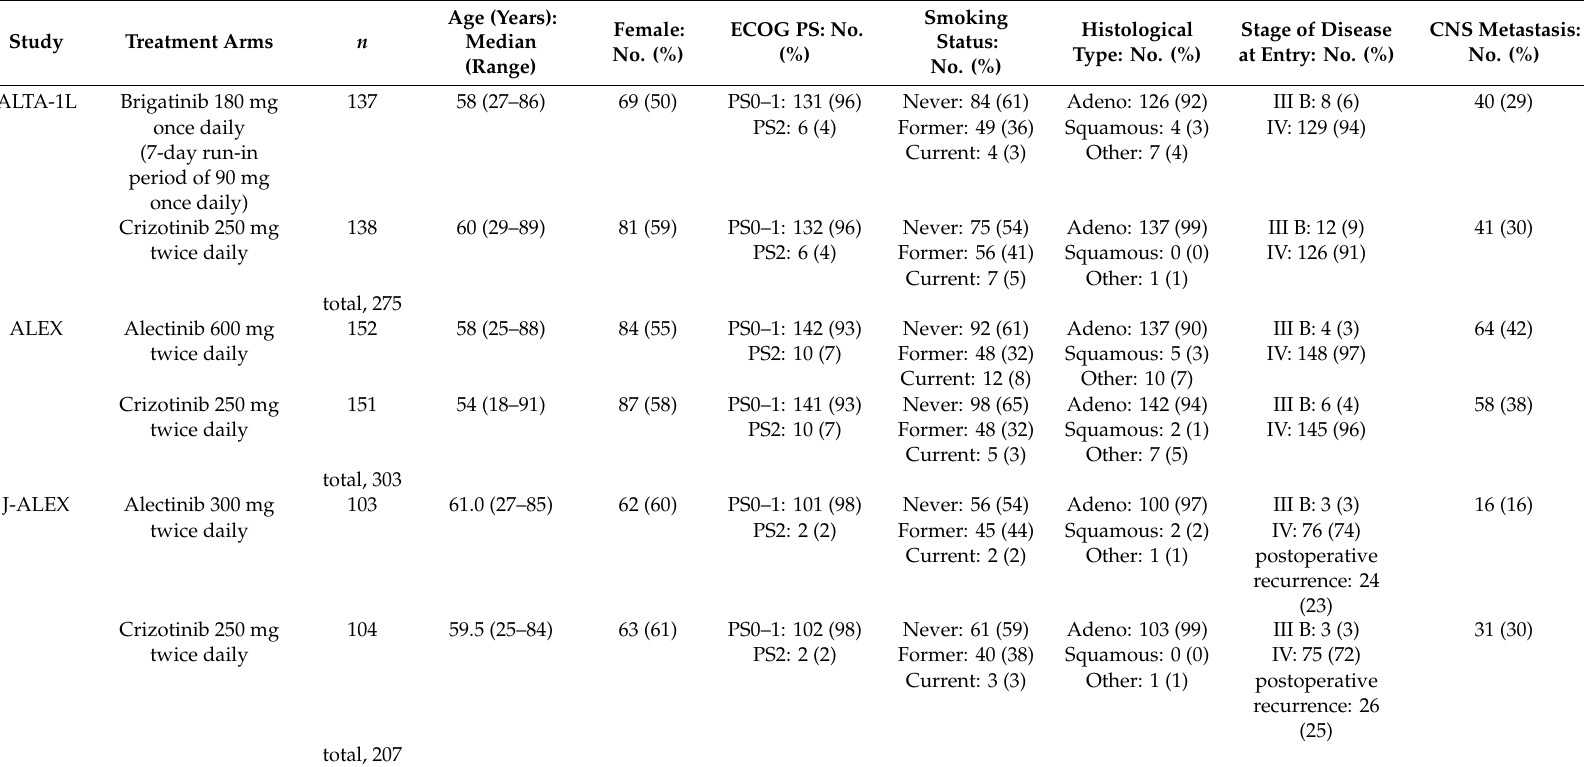
Table 2. Characteristics of